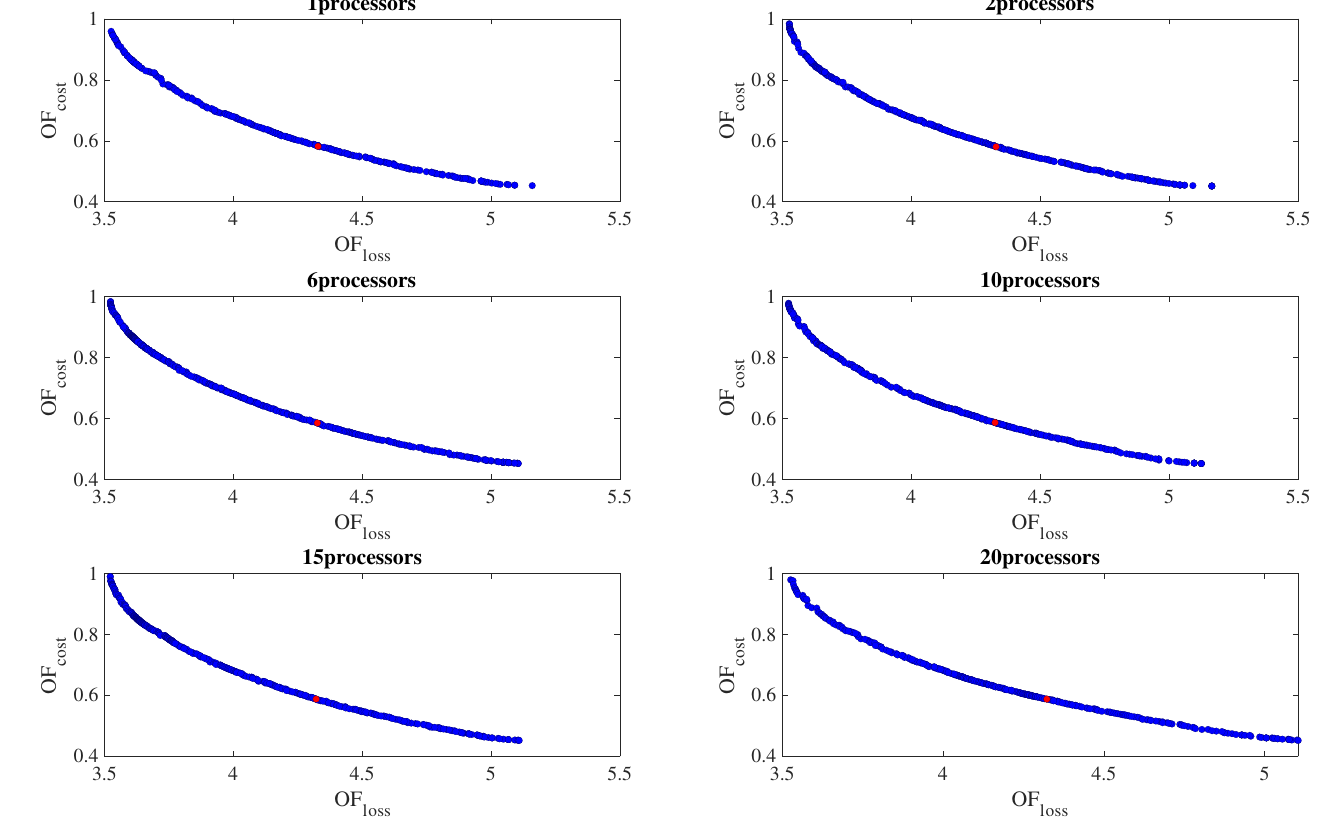
Figure 9. The non-dominated Pareto solutions for different numbers of processors and